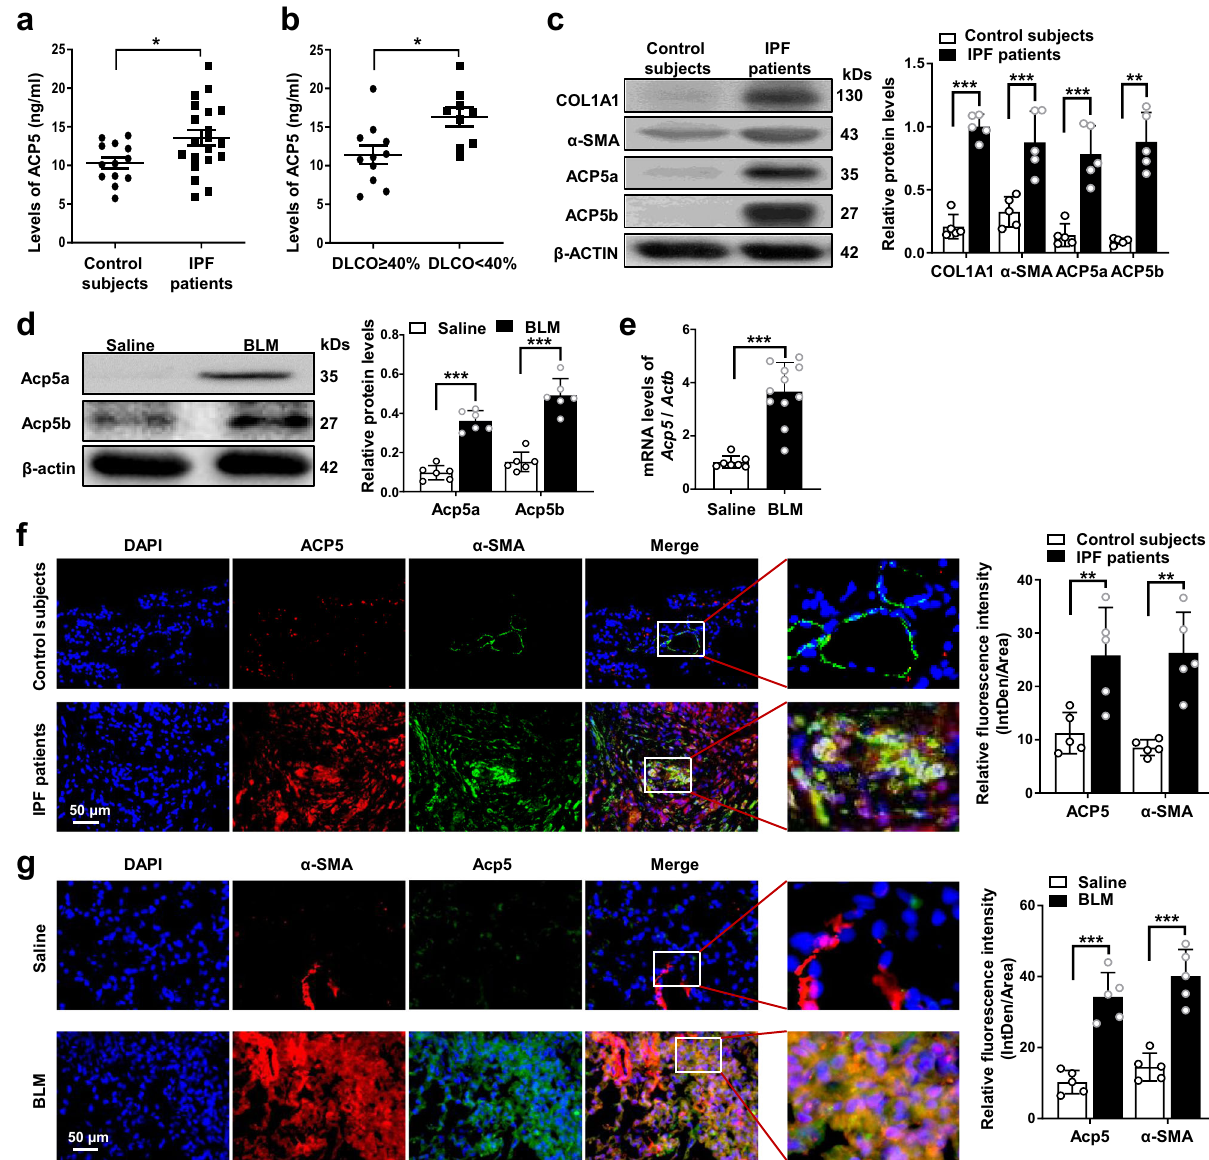
Fig. 1 Analysis of ACP5 levels in Idiopathic pulmonary fi brosis (IPF) patients and mice with bleomycin (BLM) induction. a ELISA analysis of ACP5 levels in the serum of patients with IPF ( n = 20) and control subjects ( n = 13, p = 0.0134). b Analysis of the correlation between ACP5 levels with diffusion capacity carbonmonoxide lung (DLCO)% predicted in IPF patients ( n = 20, p = 0.0113). c Western blot analysis of ACP5a ( p = 0.002) and ACP5b ( p = 0.0015), COL1A1 ( p < 0.001) and α -SMA ( p = 0.001) expression in the lungs of control subjects ( n = 5) and IPF patients ( n = 5). d Western blot analysis of Acp5a ( p < 0.001) and Acp5b ( p < 0.001) expression in the lung homogenate of Saline ( n = 6) and BLM-induced ( n = 6) mouse model. e RT- PCR analysis of Acp5 expression in the lung homogenate from Saline (n = 6) and BLM-induced (n = 11) mice ( p < 0.001). f Representative results for coimmunostaining of ACP5 ( p = 0.0095) and α -SMA (a myo fi broblast marker, p = 0.0059) in the lung sections from patients with IPF ( n = 5) and control subjects ( n = 5). g Results for coimmunostaining of Acp5 ( p < 0.001) and α -SMA ( p < 0.001) in the lung sections from Saline ( n = 5) and BLM-induced ( n = 5) mice. The nuclei were stained blue by DAPI, and the images were taken under original magni fi cation ×400. The data are represented as the mean ± SEM. Two-sided unpaired Student ’ s t test with Welch ’ s correction ( a, c, d, f, g ) and two-sided Student ’ s t test ( b, c, e, f ) were applied. * p < 0.05; ** p < 0.01; *** p < 0.001. Source data are provided as a Source Data fi le. in fi broblasts is controlled by canonical TGF- β signaling, of which TGF β R1/Smad3 are essential mediators.